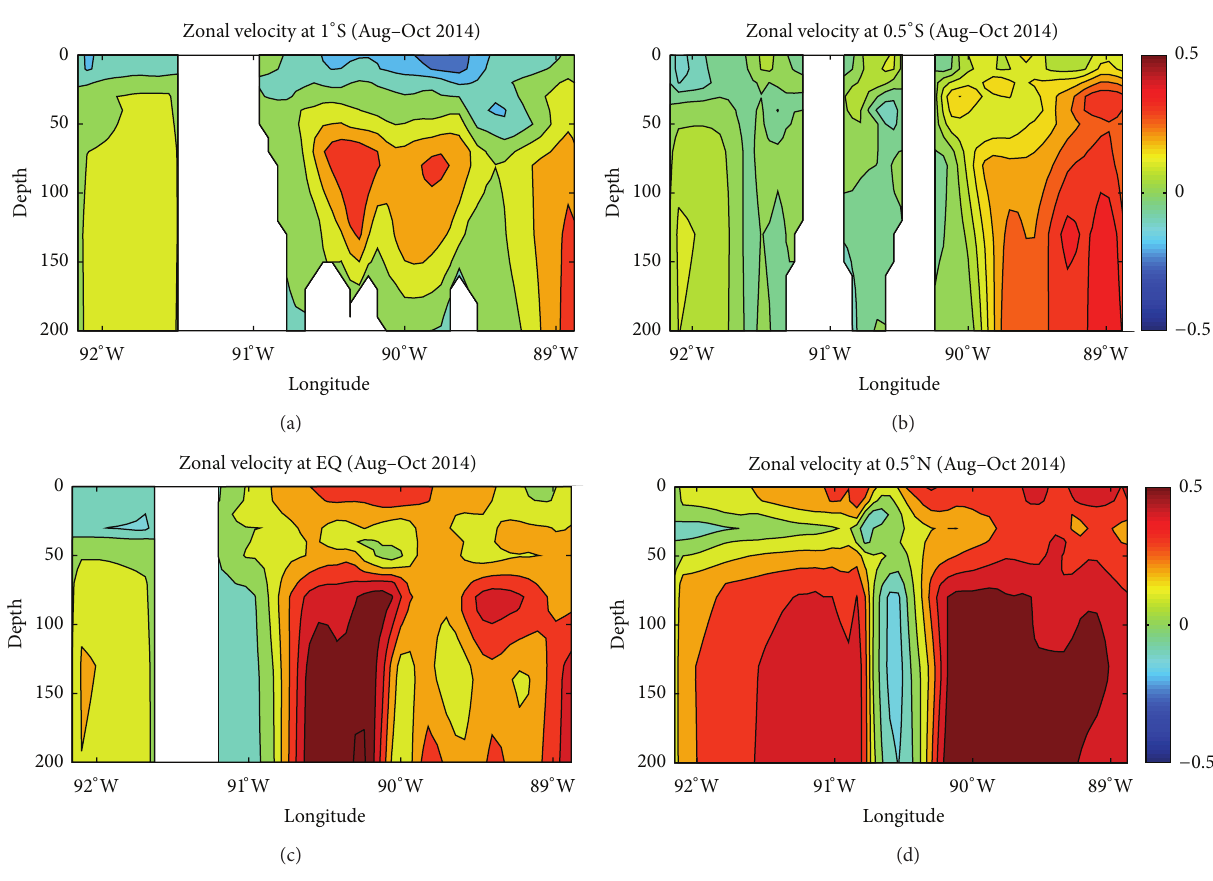
Figure 18: Vertical sections of zonal current (ms −1 ) along 92 ∘ W, 91.8 ∘ W, 90 ∘ W, and 89 ∘ W for the upper 200m around the GMR in Aug–Oct 2014 La Ni˜na